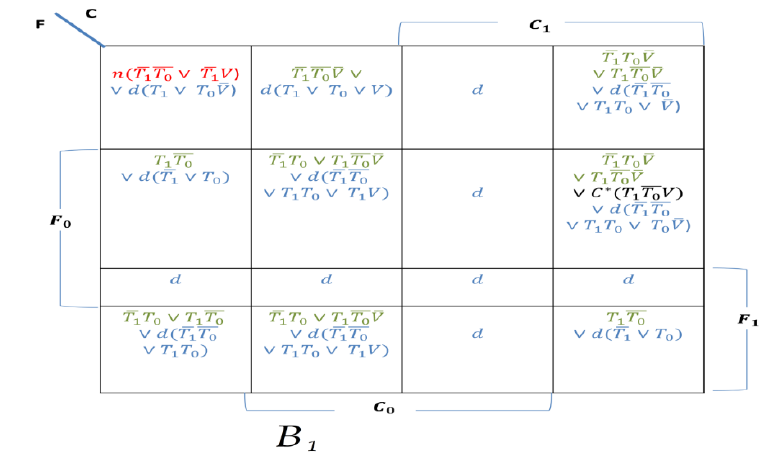
Fig. 8. A variable-entered-Karnaugh-Map representation of B 1 (party bans introduction), a compact version